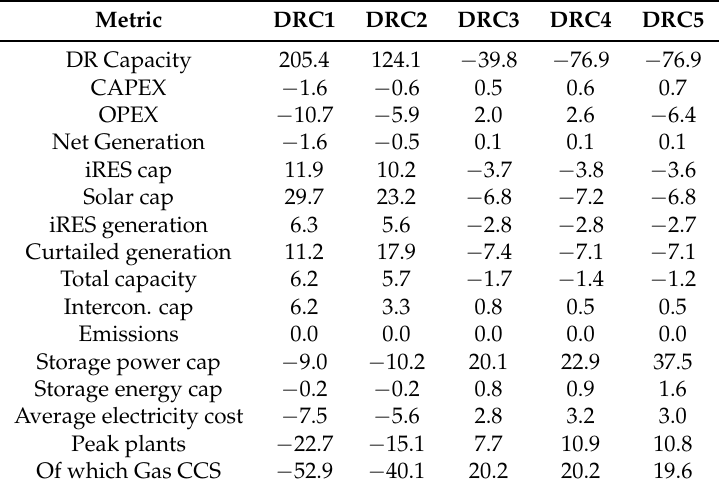
Figure 8. Europe’s Capacity Development by year between DRB and DRC1-5 cases. Table 4. DR costs sensitivity’s percentage variation analysis respect to DRB